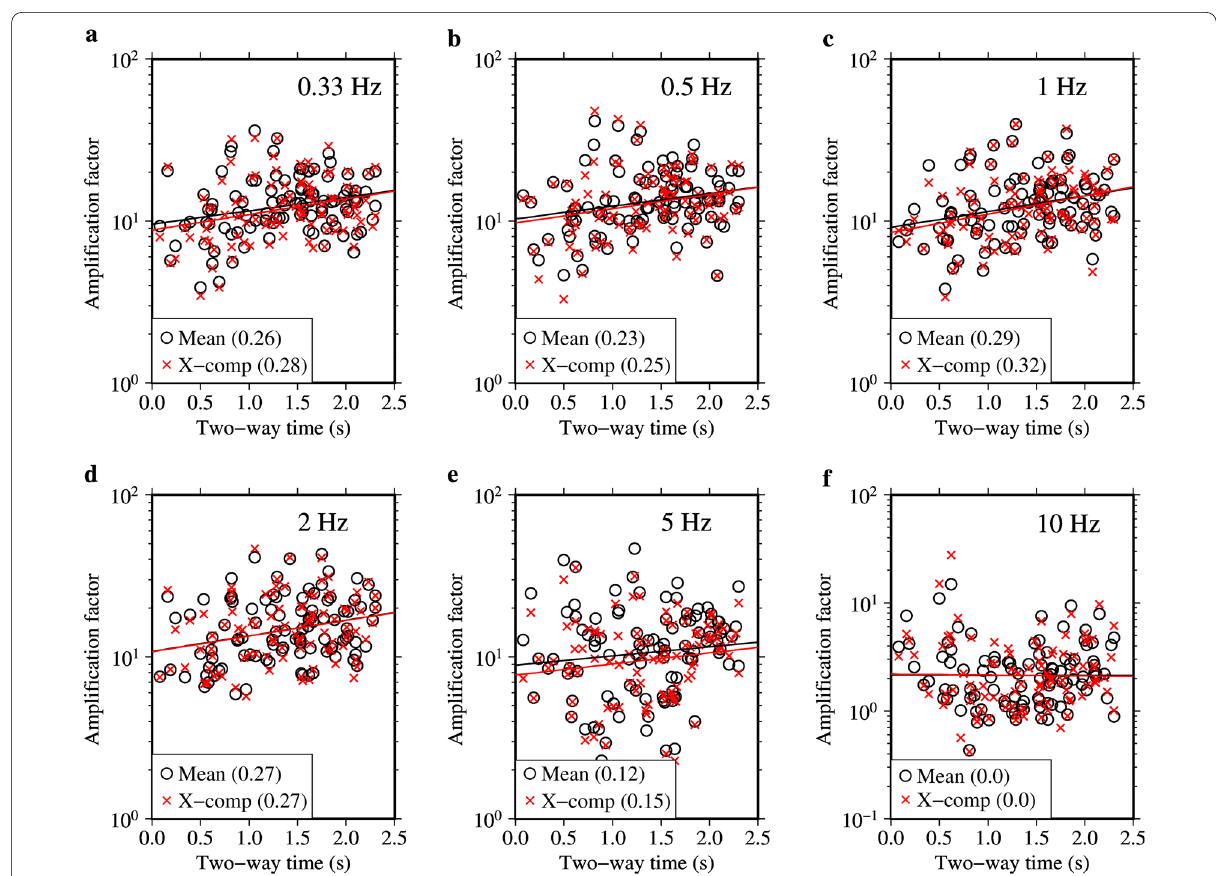
Fig. 15 Relationships between the two-way travel times for P wave and site amplification factors at frequencies of approximately 0.33, 0.5, 1, 2, 5, and 10 Hz (panels a – f ), respectively. The red and black lines indicate the linear fits between the travel times and logarithms of amplification factors. The numerals in parentheses indicate the values of correlation coefficients between the corresponding data sets. Note the difference in the scale of the vertical axis for 10 Hz f compared to the scales for other frequencies. The amplification factors are lower than five for 10 Hz at most